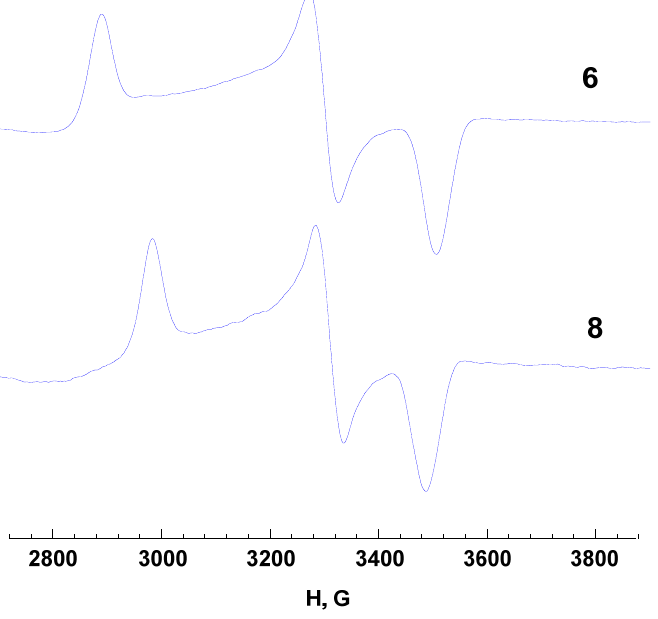
Figure 2. Anisotropic EPR spectra of ruthenacarboranes 6 and 8 in the toluene matrix at 77